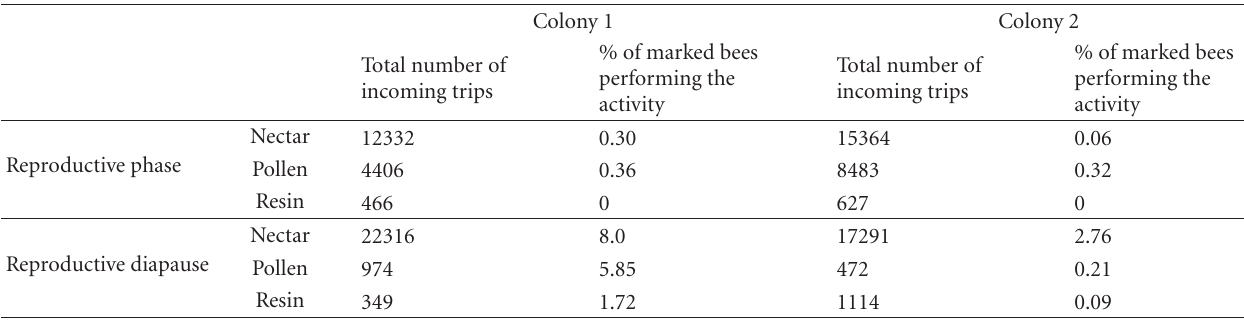
Table 3: Total number of incoming trips of nectar, pollen, and resin and the percentage of marked bees that performed these activities during the reproductive phase and reproductive diapause in colonies 1 and 2 of Plebeia remota